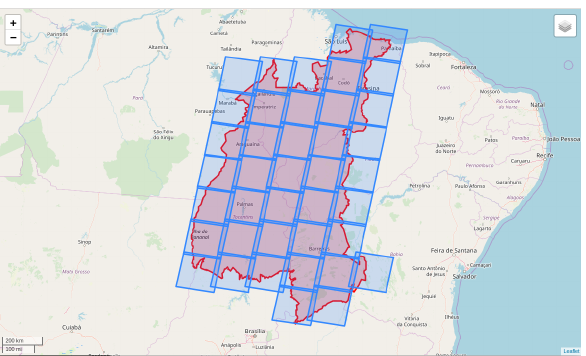
Figure 2. Map of study area overlaid by the Landsat 8 tiles 2